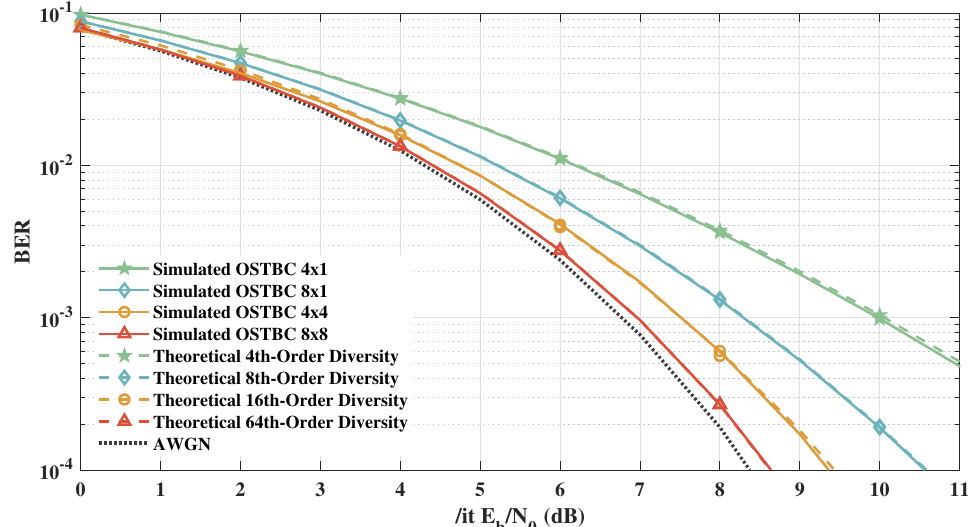
Figure 8. Simulated and theoretical results for 4th, 8th, 16th, and 64th diversity orders.